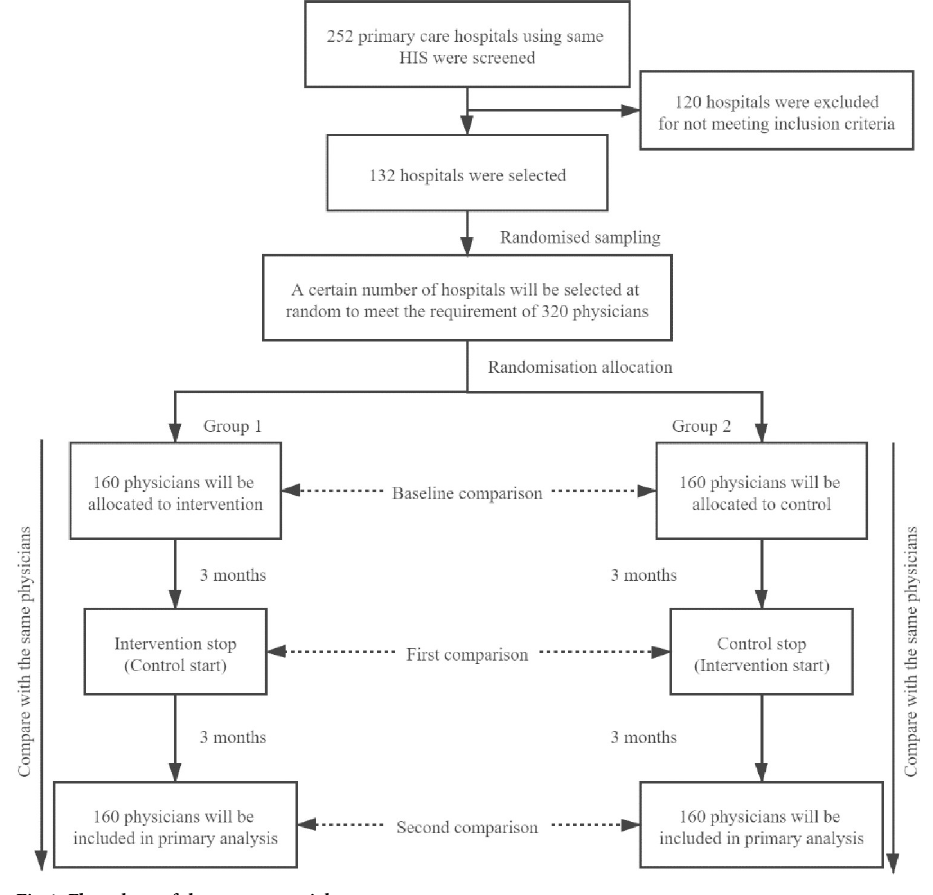
Fig 4. Flow chart of the crossover